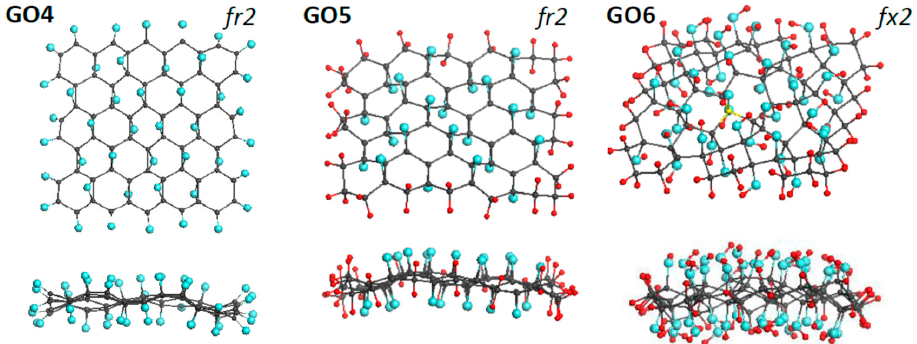
Figure 5. Face and side view of equilibrium structures of virtually synthesized monochrome graphene oxides GO4 (C 66 O 44 ), GO5 (C 66 H 44 O 22 ), and GO6 (C 66 O 44 H 88 ). Gray, blue, and red balls mark carbon, oxygen, and hydrogen atoms, respectively. UHF AM1 calculations.